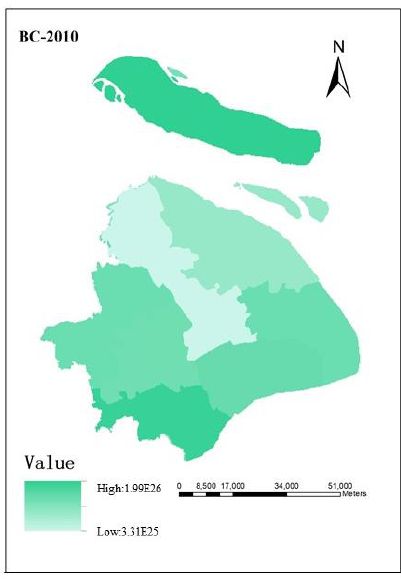
Figure 10. Spatial pattern of biodiversity conservation service of Shanghai in 2010 (sej / yr).